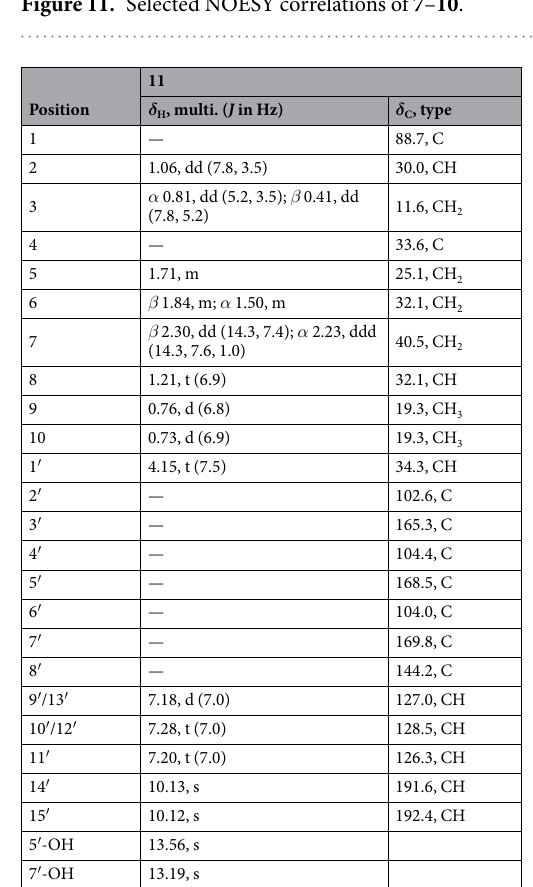
Figure 11. Selected NOESY correlations of 7 – 10 .